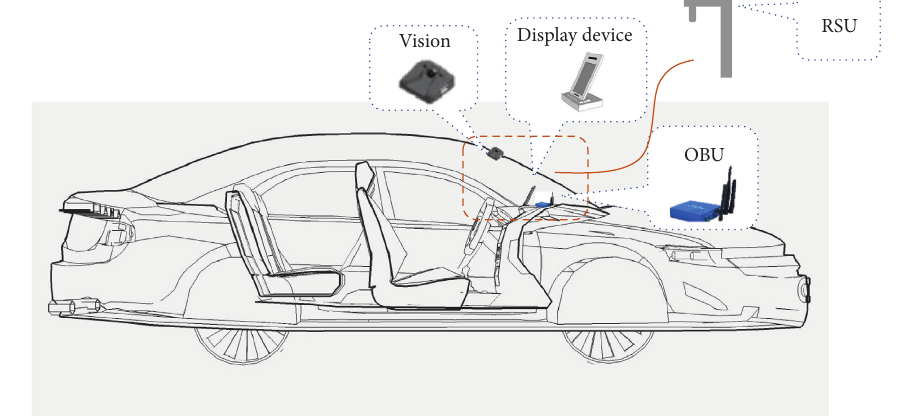
Figure 1: Configuration of the proposed SCWS.